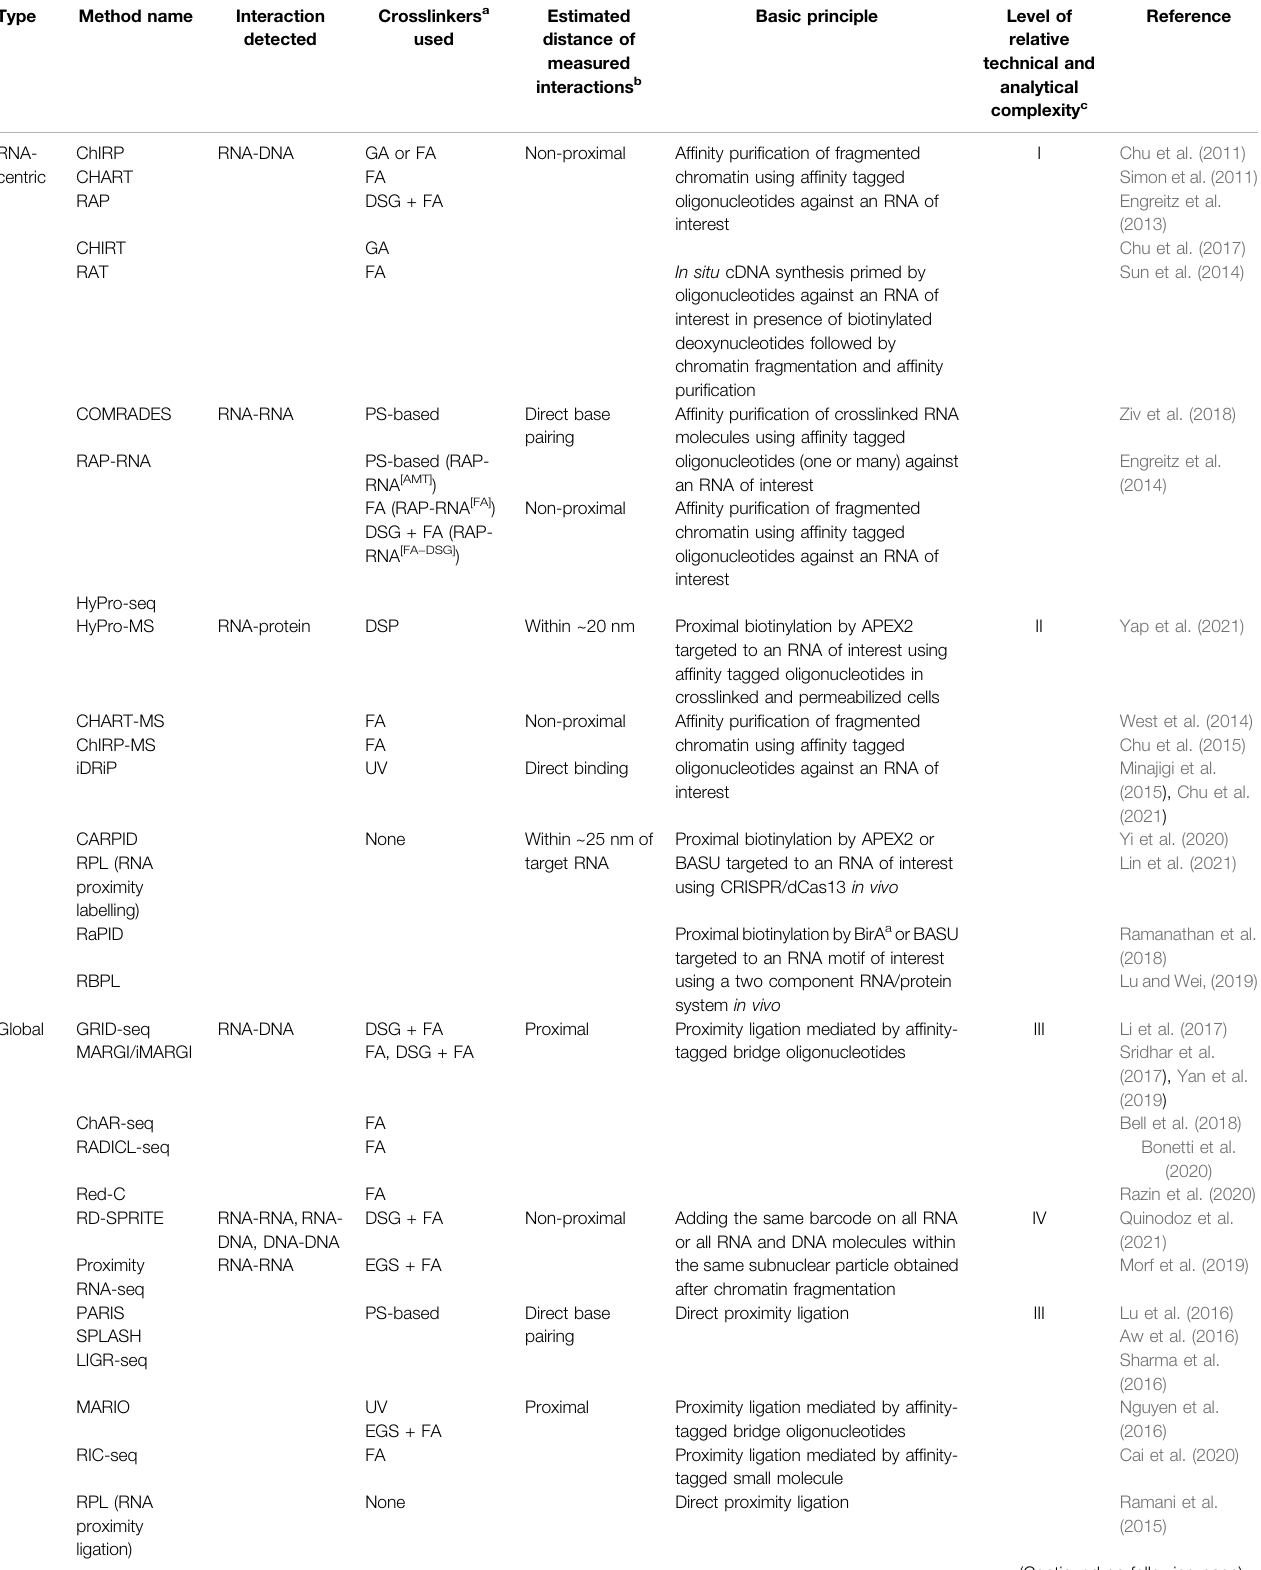
TABLE 1 | Summary of the RNA interactome mapping